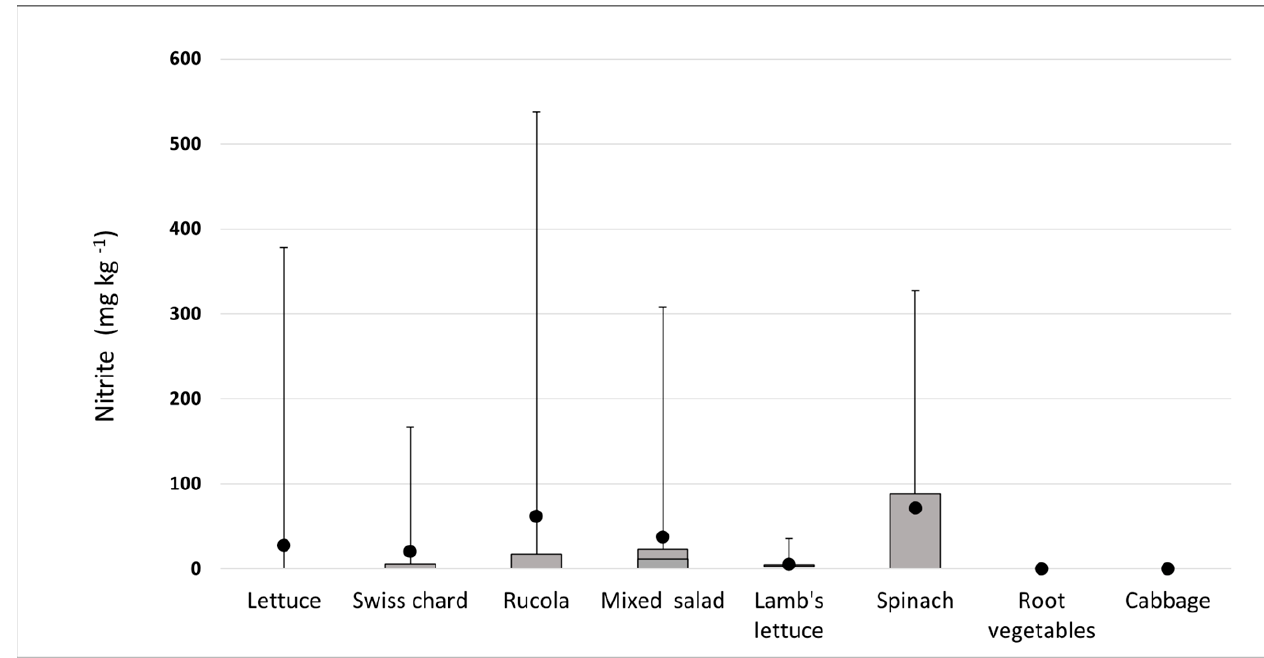
Figure 5. The results of the determination of the nitrite concentrations depending on the variables are shown as the mean value (•); maximum ( ); minimum ( ); and interquartile range with median ( □ ).